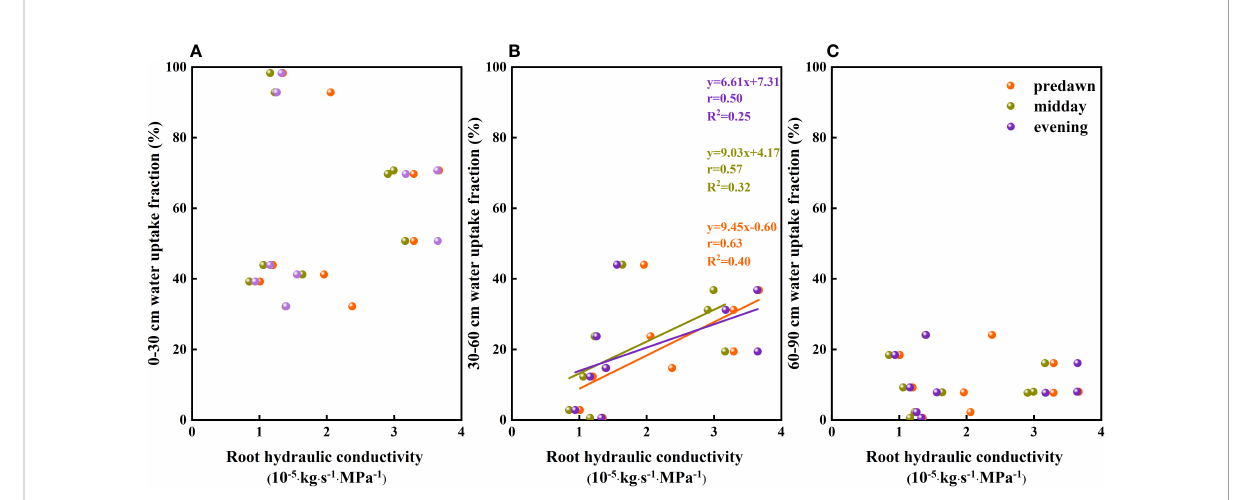
FIGURE 5 The relationship between the soil water uptake fraction and root hydraulic conductivity of Ferula bungeana. (A – C) present data for the 0 – 30 cm, 30 – 60 cm, and 60 – 90 cm soil layers,